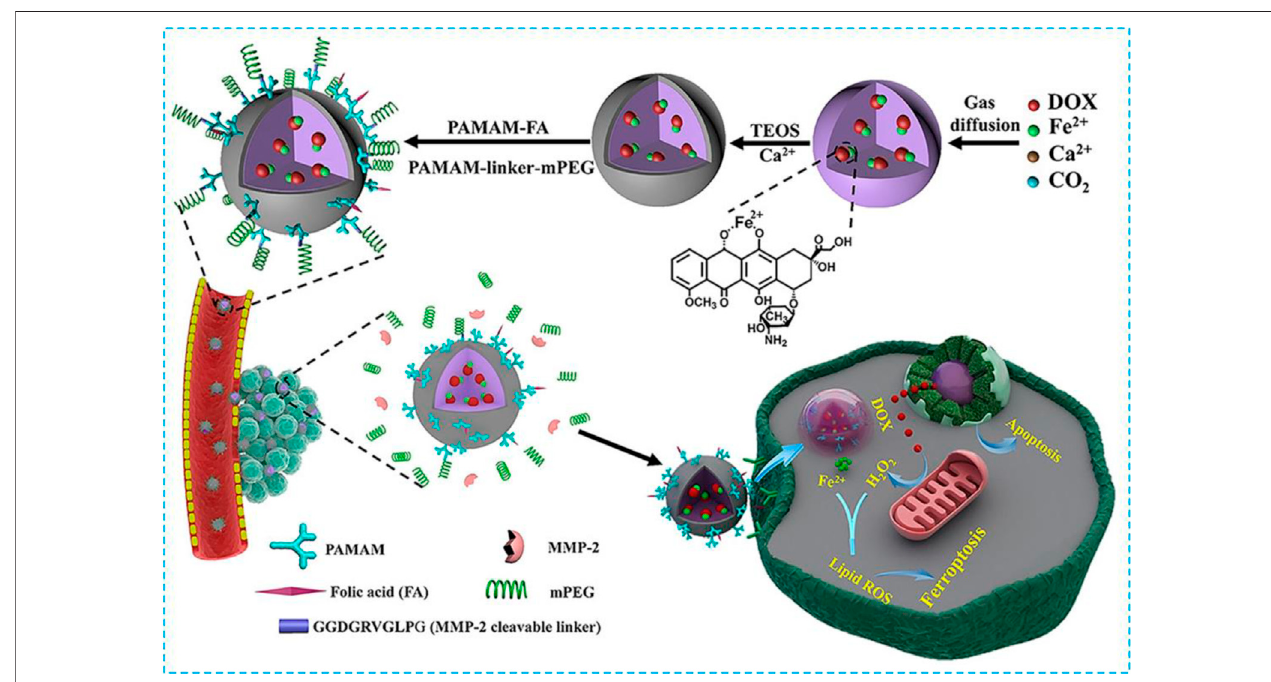
FIGURE 8 | Synthesis scheme of ACC@DOX.Fe 2+ -CaSi-PAMAM-FA/mPEG and its complementary ferroptosis/apoptosis-based therapeutic action. Reprinted with permission from Ref. (Xue et al., 2020). Copyright 2020 The Authors.